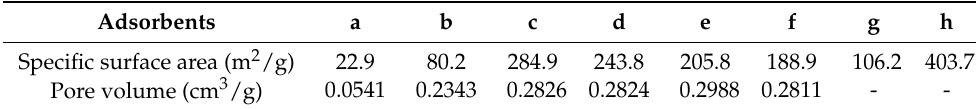
Table 2. The surface structures of different adsorbents.